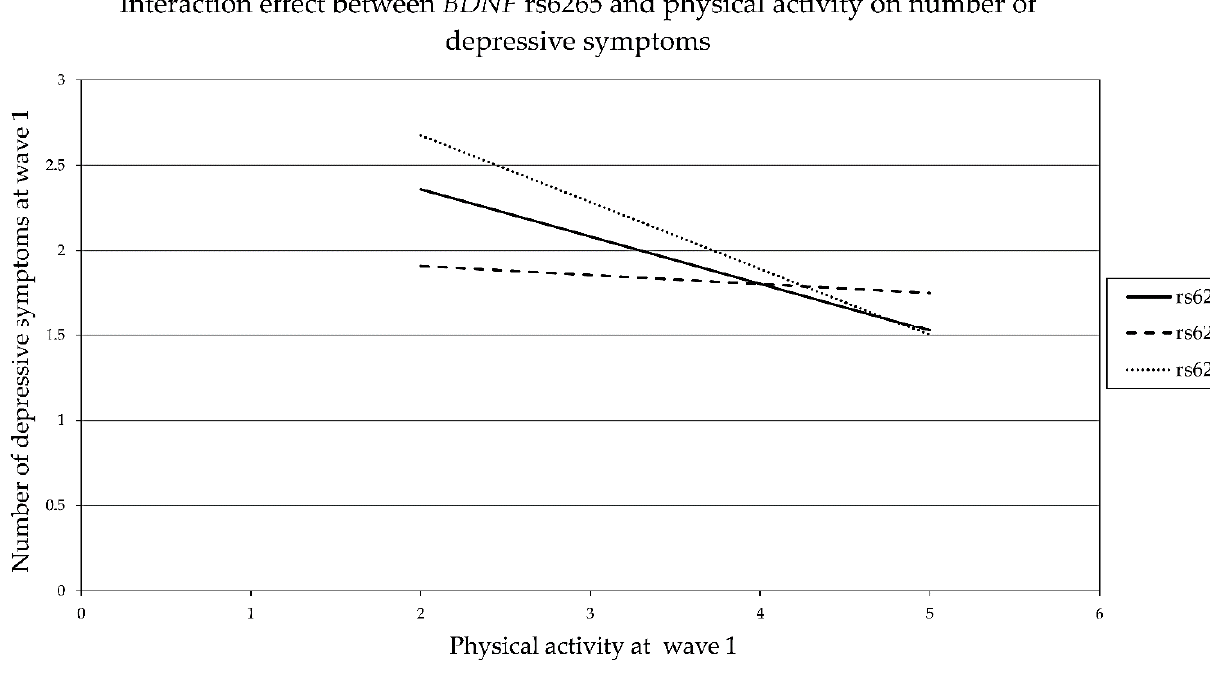
Figure 2. Interaction between BDNF rs6265 and physical activity in wave 1 (Model 1). Lines in the figure represent obtained data of the conditional effect of BDNF rs6265 GG, GA and AA at different levels of physical activity on the number of depressive symptoms.